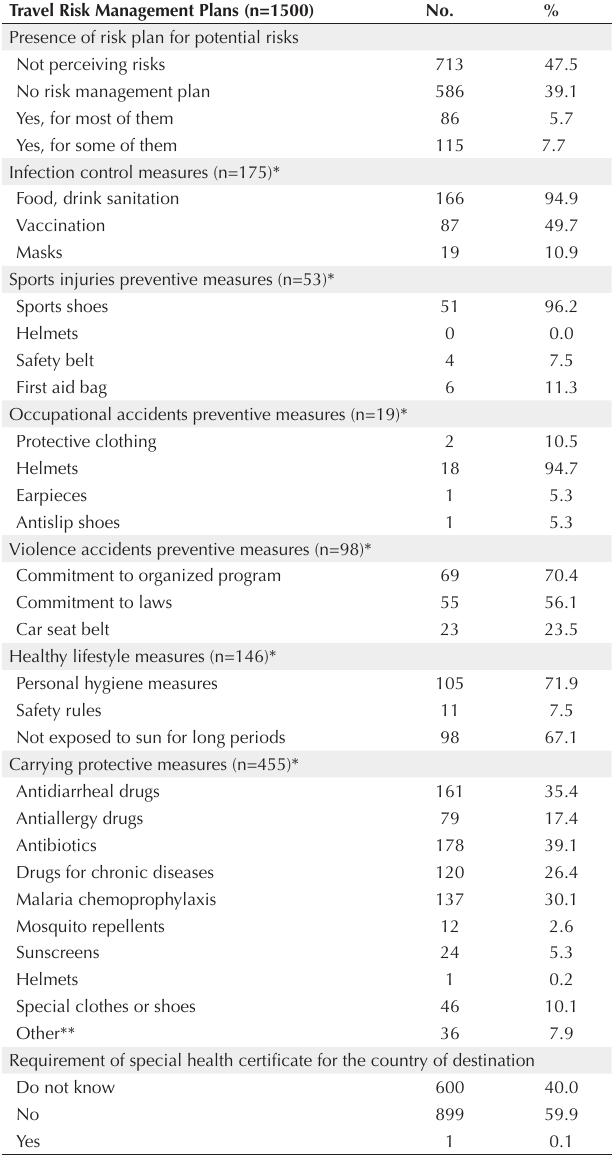
Table 3. Distribution of Travelers at Cairo International Airport According to Travel Risk Management